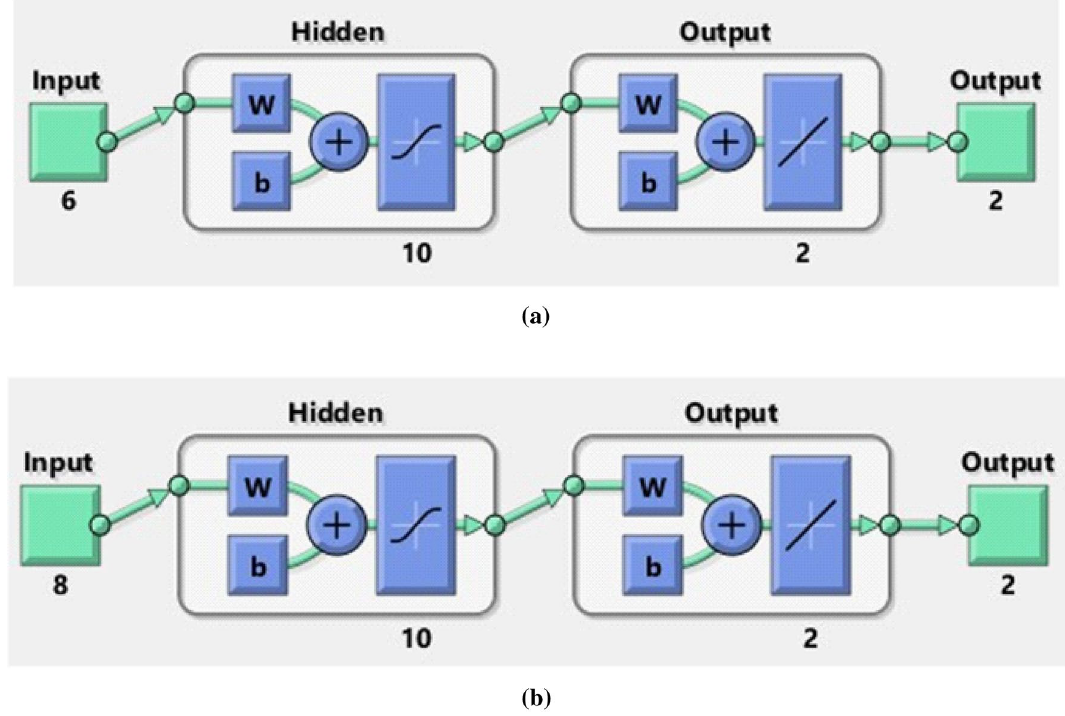
Figure 2. The basic structures of the ANN models ( a ) SFCs ( b )